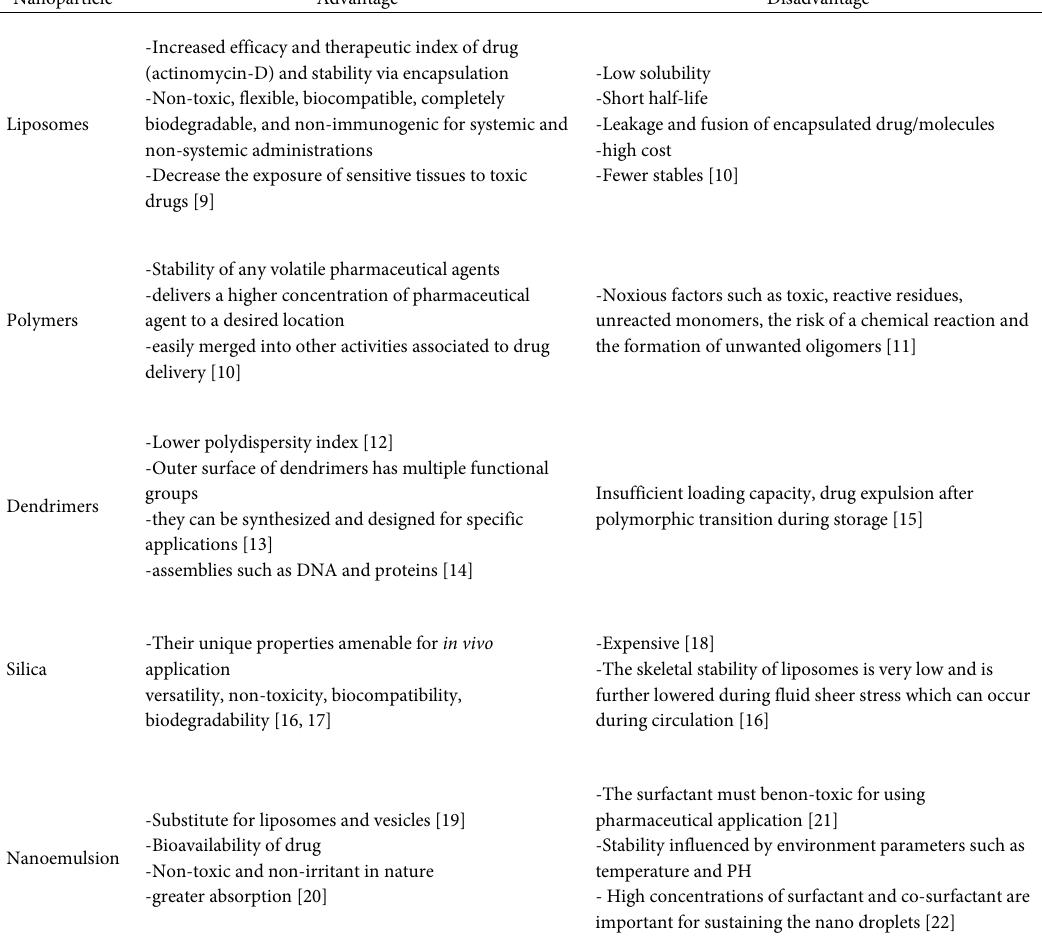
Table 1. Some of the main advantages and disadvantages of routine nanoparticles